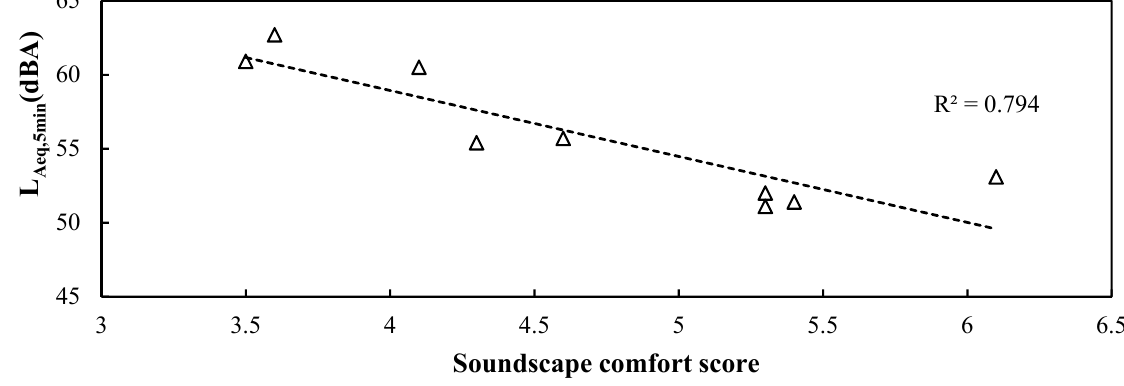
Figure 8. TherelationshipbetweentheL Aeq,5min andthesoundscapecomfortscoreateachsoundwalk Figure 8. The relationship between the L Aeq,5min and the soundscape comfort score at each soundwalk point.